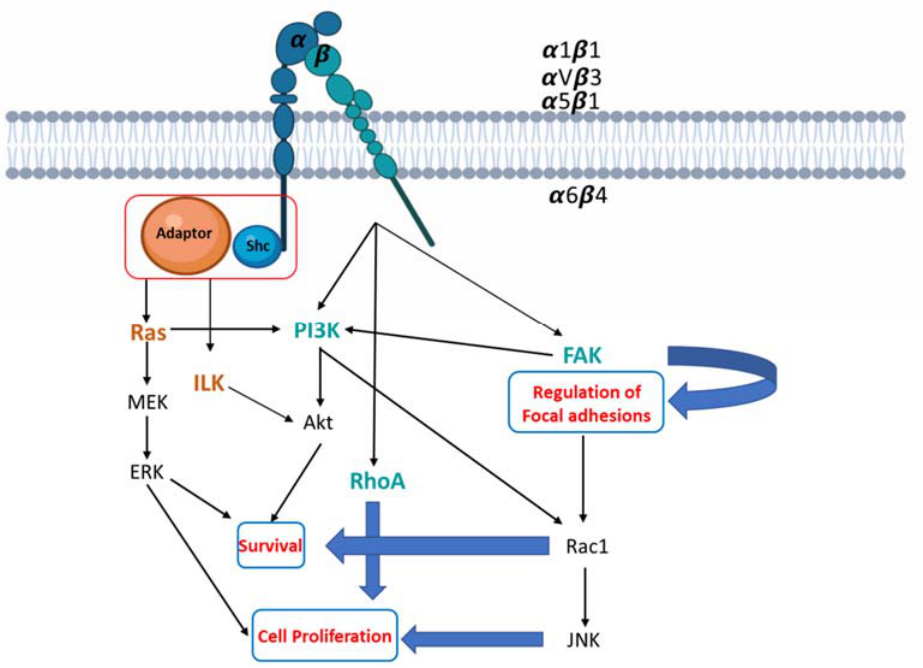
Figure 2. Integrin-mediated signaling pathways leading to cell proliferation and survival. Schematic representation of the multiple signaling pathways activated by integrins and affecting cell proliferation and survival. Integrins regulate cell survival via Ras/MEK/ERK, ILK/Akt (both requiring the Shc subunit and an adaptor protein), and PI3K (through Akt or Rac1) signaling pathways. In addition, proliferation is mediated by Ras/MEK/ERK, RhoA, PI3K, and FAK, the latter also being involved in the regulation of focal adhesions.